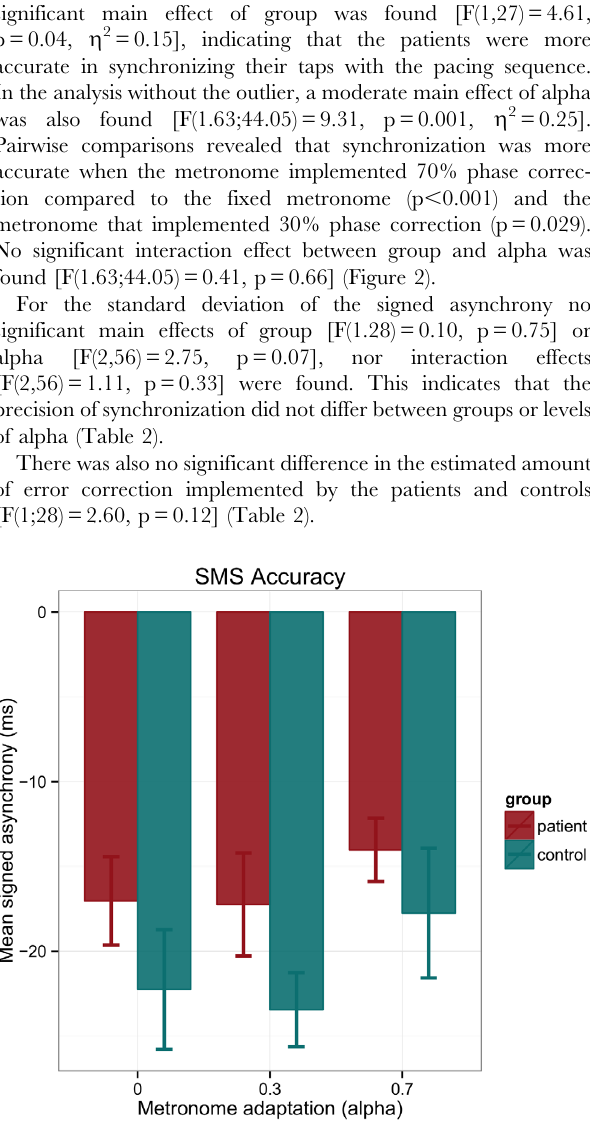
Figure 2. Adaptive tapping task accuracy results. Mean signed asynchronies as a measure of sensorimotor synchronization accuracy separated for group and levels of alpha. By convention negative values indicate that the tap preceded the tone. Error bars indicate standard error of the mean.